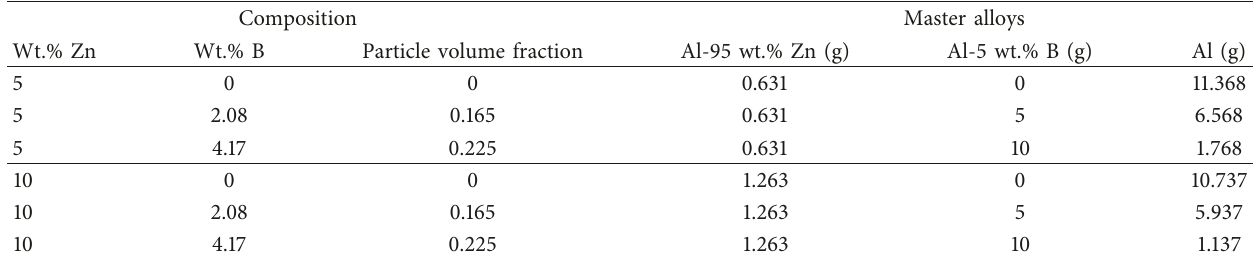
Table 1: Master alloys’ chemical